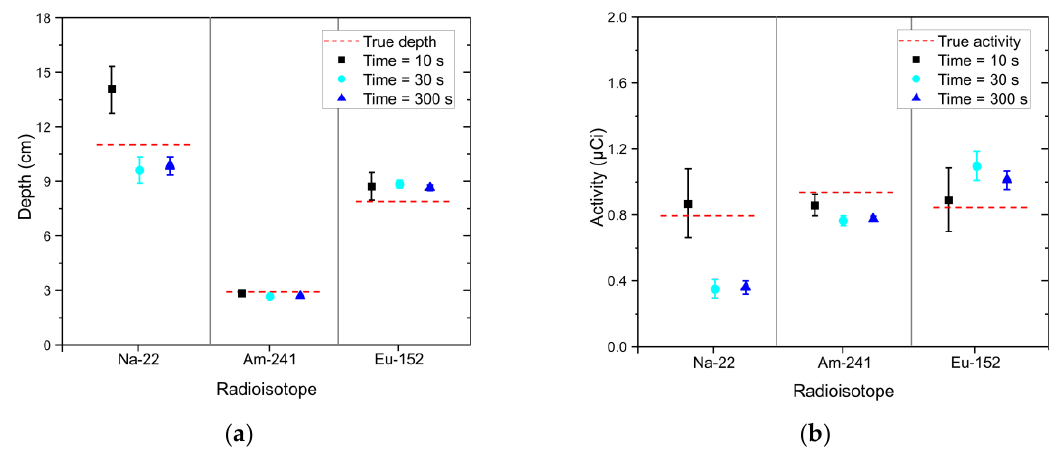
Figure 11. ( a ) Estimated depth and ( b ) activity of identified radioisotopes (i.e., Na-22, Am-241, and Eu-152) in the form of mean and 1.96 standard error analyzed for experimental spectra with acquisition times of 10 s (black square), 30 s (sky-blue circle), and 300 s (blue triangle). The spectra were acquired with Na-22, Am-241, and Eu-152 sources buried in sand at depths of 11 cm, 3 cm, and 8 cm, respectively. The red dotted lines denote the true values.